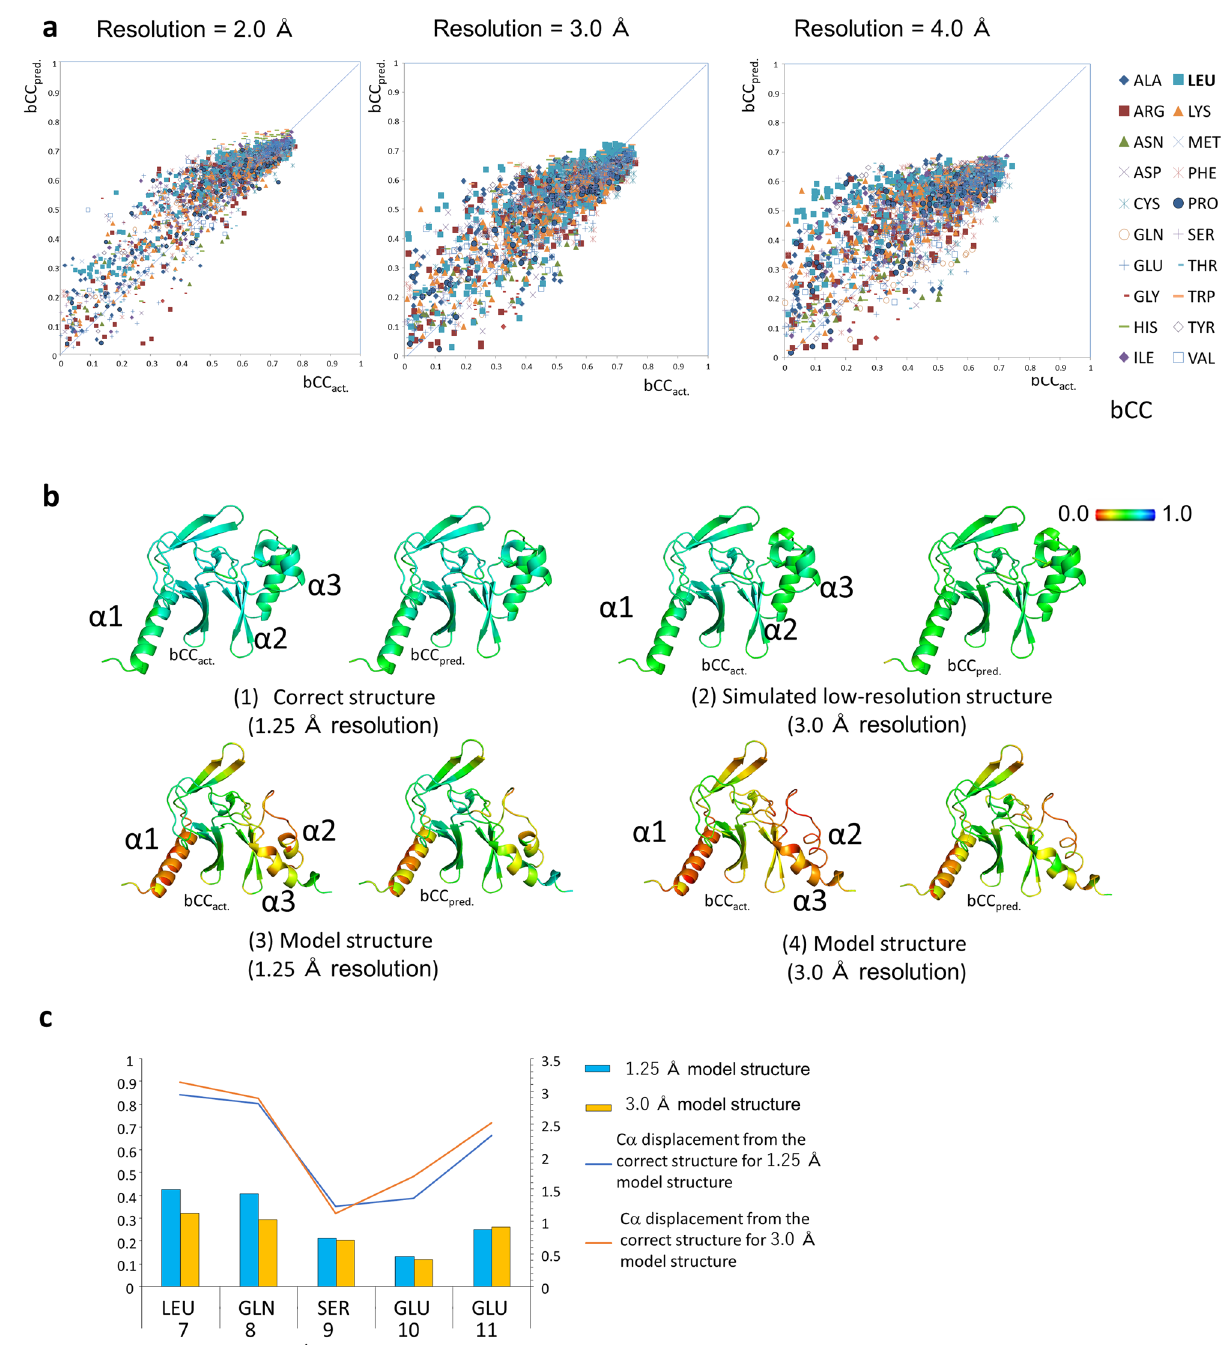
Figure 5. Evaluation of QAEmap with test data. ( a ) Correlation between bCC act. and bCC pred . The correlation coefficients are 0.890 at 2.0 Å, 0.848 at 3.9 Å, and 0.736 at 4.0 Å resolution for all amino acids. ( b ) bCC act. and bCC pred. for the correct structure of PDB: 3F9X (1), Simulated 3.0 Å-resolution structure (2); model structures at 1.25 Å (3) and 3.0 Å (4) resolution. The structures are presented with bCC values in rainbow color. ( c ) The bCC pred . values of the model structures of Fig. 3b. Although the coordinates and electron density of the input are the same as those of the RSCC (Supplementary Fig. S1 (right)), the bCC pred. values show no correlation with the correct electron density with bCC pred. values < ~